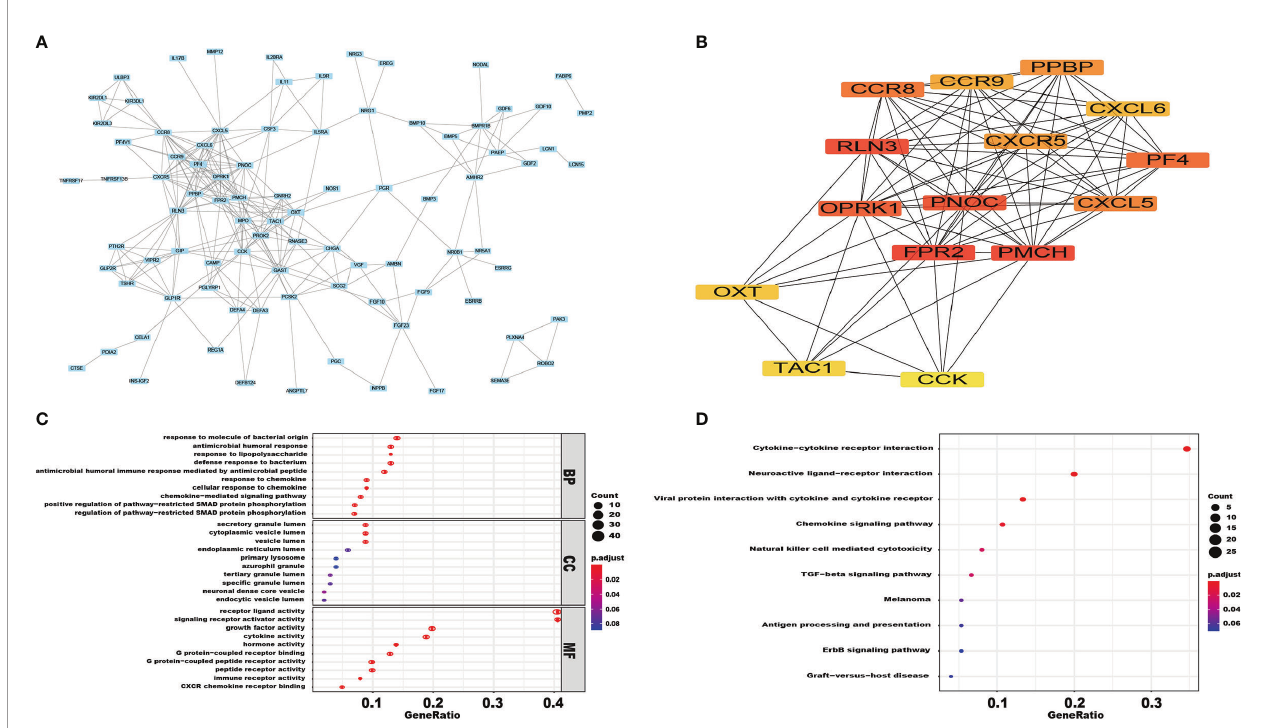
FIGURE 2 | The functional enrichment analysis of differentially expressed IRGs. PPI network (A) of IRGs and the hub IRGs (B) . The top pathways of IRGs were shown in biological process (BP), cellular component (CC), molecular function (MF) (C) , and top KEGG pathways (D)